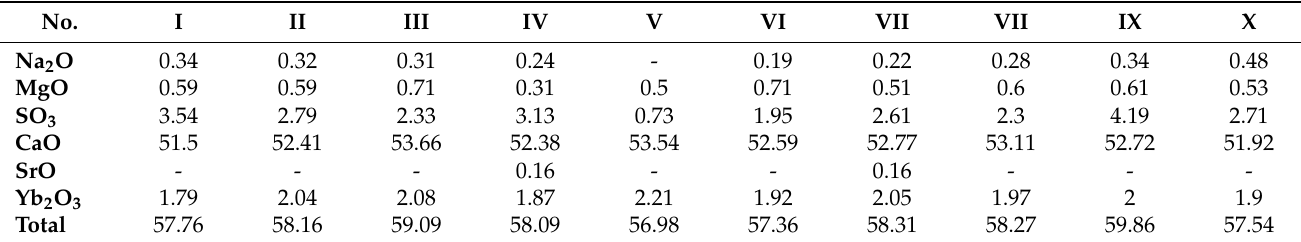
Figure 3. Evaluated XRD pattern. Table 1. Representative microanalyses of